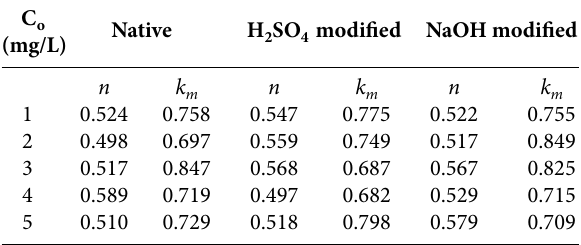
Table 5. Estimated Transport number at various initial concentra- tion of As(III) ions C o Native (mg/L)